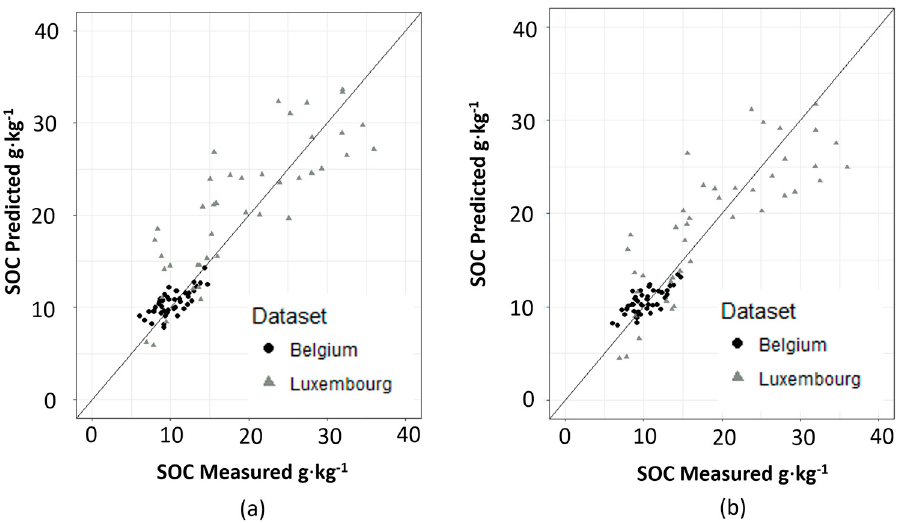
Figure 5. Plot of measured against estimated soil organic carbon content obtained by traditional ( a ), and bottom-up ( b ), approaches on the independent validation datasets in Belgium and Luxembourg.